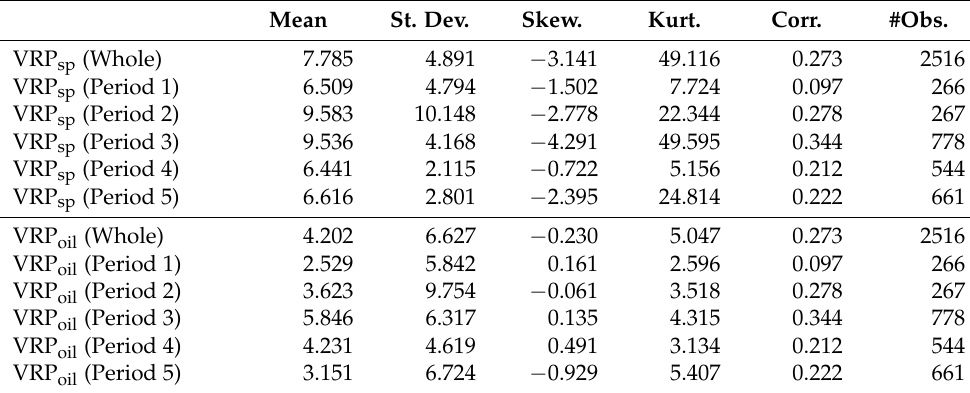
Table 2. Descriptive statistics of VRP sp and VRP oil . Mean St. Dev. Skew. Kurt. Corr.